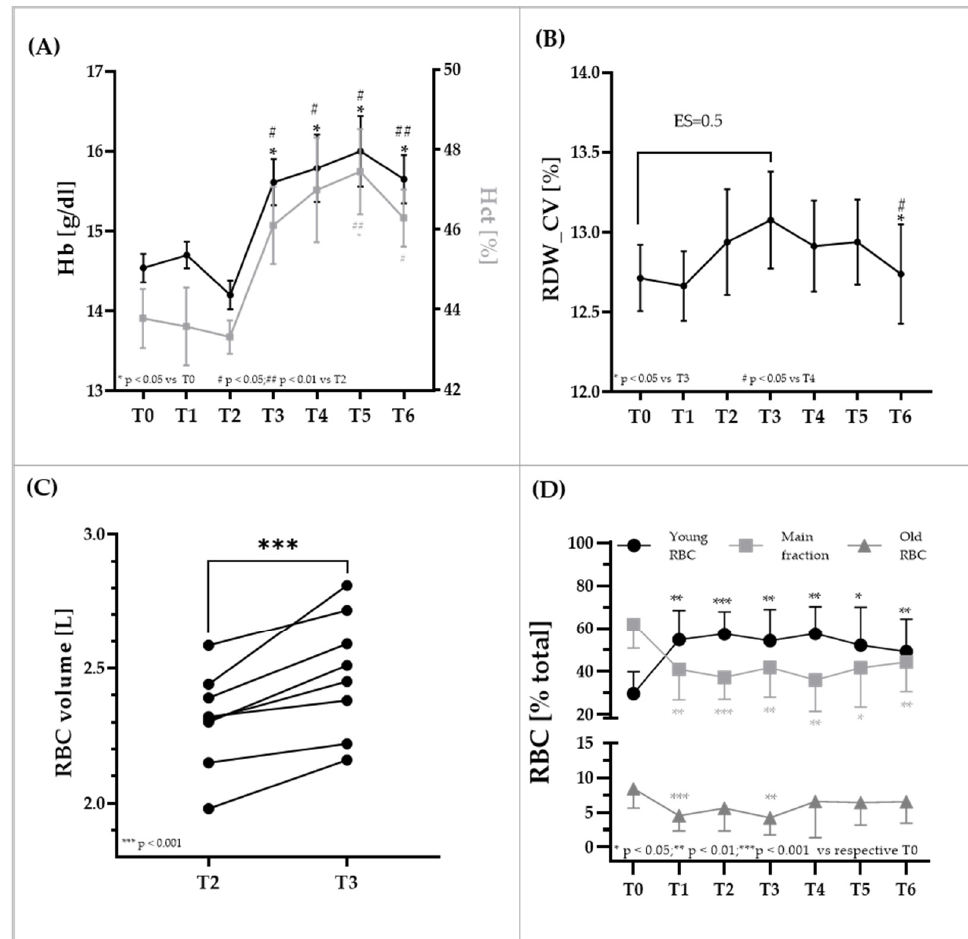
Figure 2. Changes in RBC parameters during blood sampling and after transfusion. ( A ) Hemoglobin concentration (black line) and hematocrit (grey line) significantly increased after RBC transfusion (=T3) and further increased until day three after transfusion (T5). Values decreased seven days after transfusion (T6). ( B ) Values of RBC distribution width might indicate an increase at time of transfusion (T3) and lower values observed seven days after transfusion (T6) compared to post transfusion (T3). ( C ) RBC volume significantly increased from T2 to T3. ( D ) RBC age distribution significantly changed after first blood donation. Percentage of young RBC (black) significantly increased after T0, while percentage of main fraction (light grey) and old RBC (dark grey) decreased, respectively. Data are mean (SD).